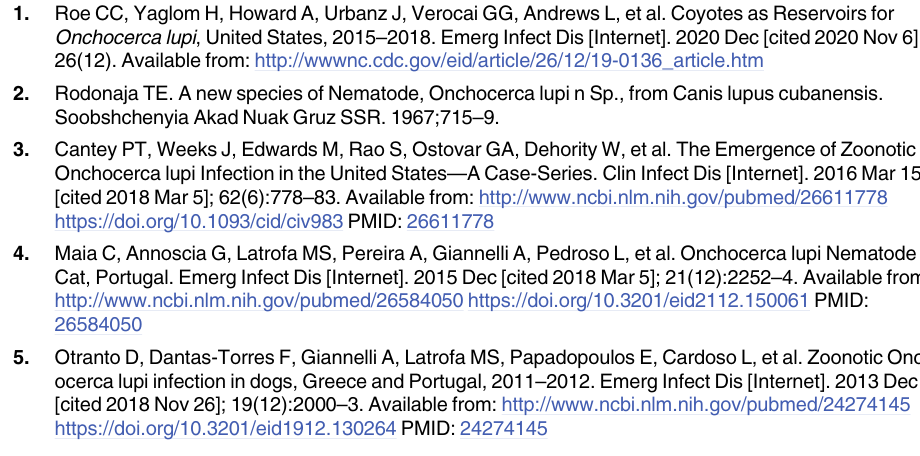
S1 Table. Accession information for polycystin-1 precursor ( pkd1 ) gene sequences included for host locus primer design. S2 Table. Accession information for read data used for parasite locus primer